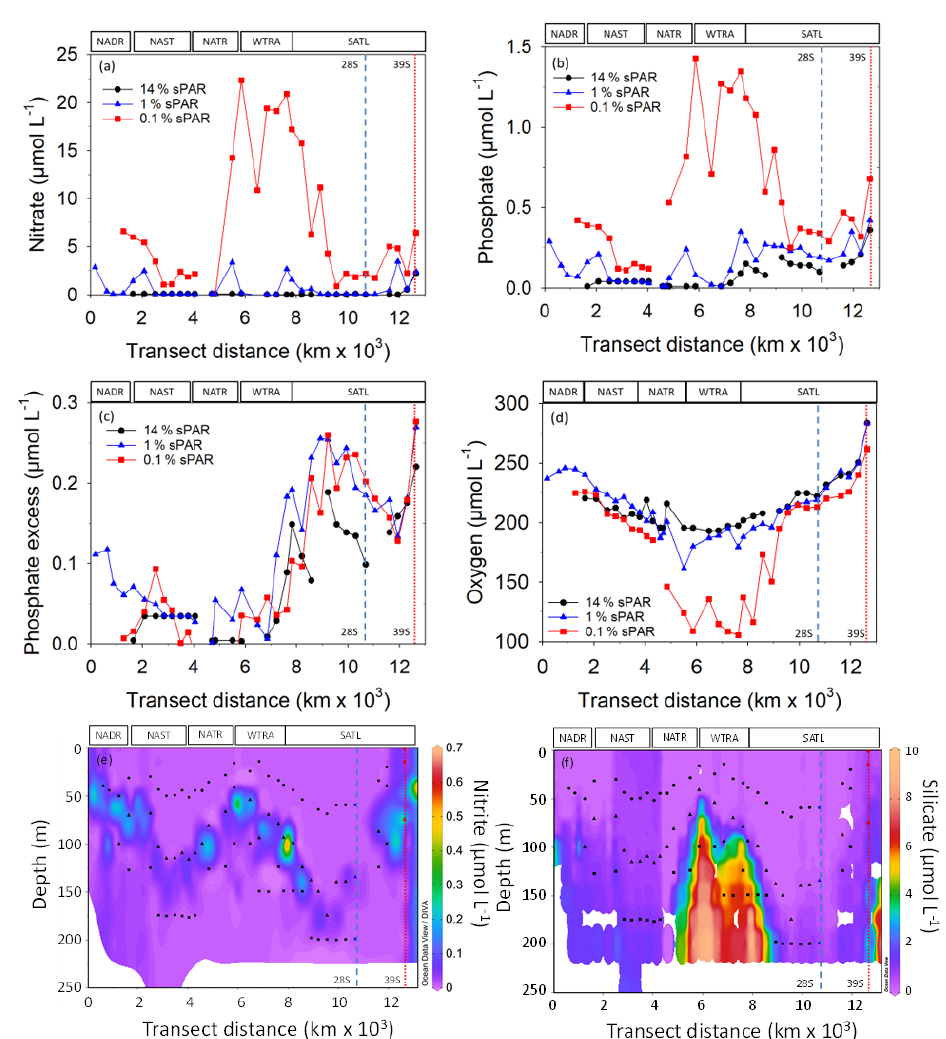
Figure 3. The concentration of nitrate (a) , phosphate (b) , phosphate excess ( P ∗ ; c ), oxygen (d) , nitrite (e) , and silicate (f) . The locations of two eddy features are indicated by vertical dashed (28 ◦ S) and dotted (39 ◦ S) lines. The approximate locations of Longhurst provinces (defined in Fig. 1) are indicated. Symbols represent 14% sPAR (circle), 1% sPAR (triangle), and 0.1% sPAR (square).